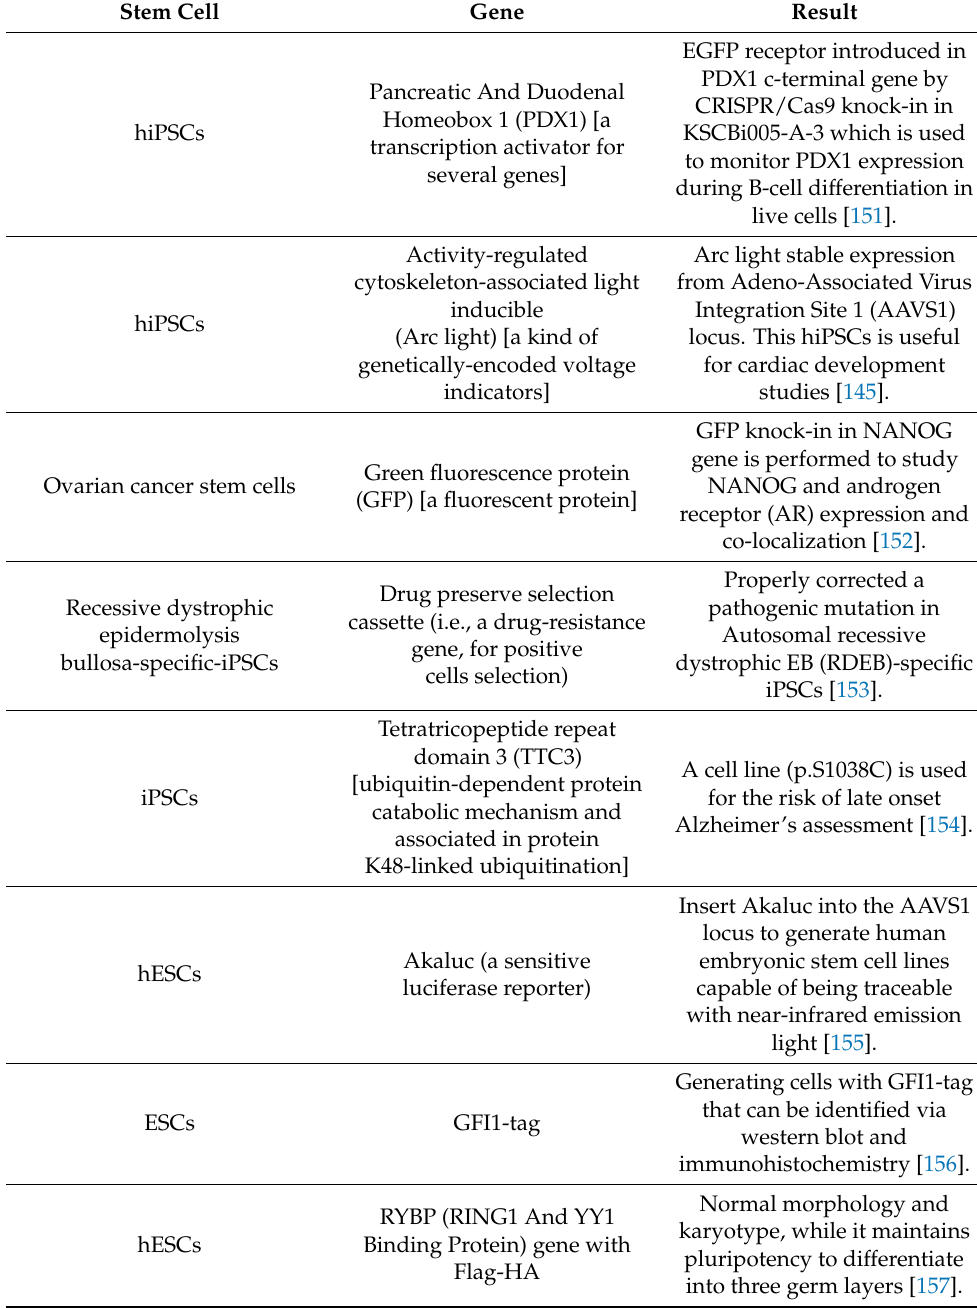
Table 3. Knock-in and application of this technology in stem cells (all the knock-ins done by using CRISPR/Cas9